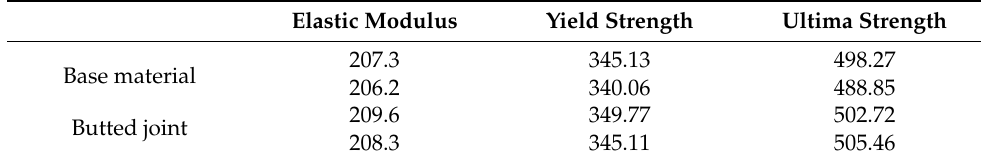
Table 2. Mechanical properties of base material and butt joint